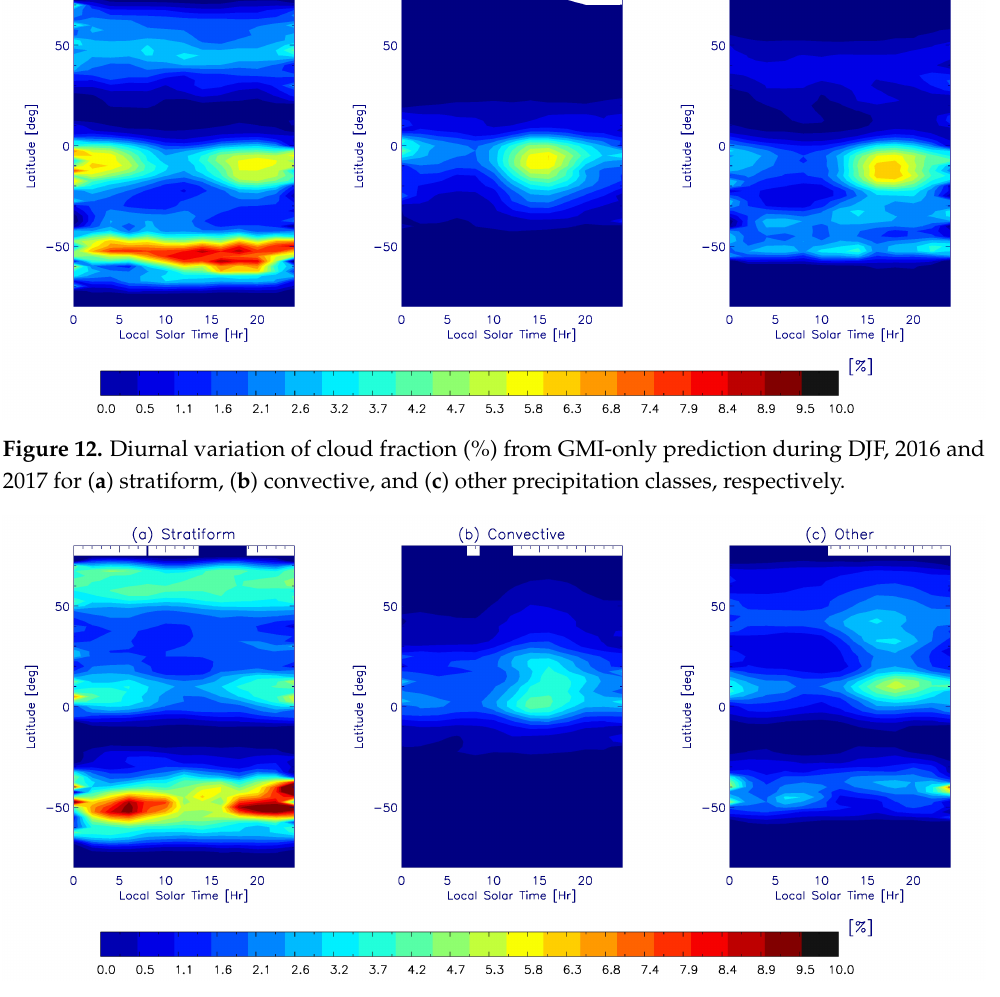
Figure 13. Same as Figure 12, except for JJA, 2016 and